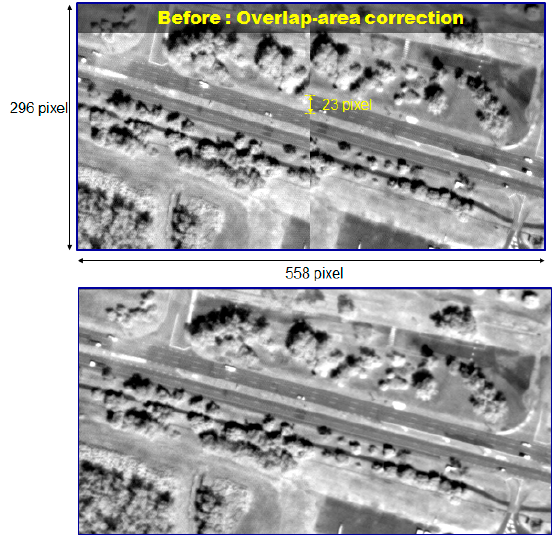
Figure 9. Comparison between before and after the merge of subimages. Sensors 2016 , 16 , 1776